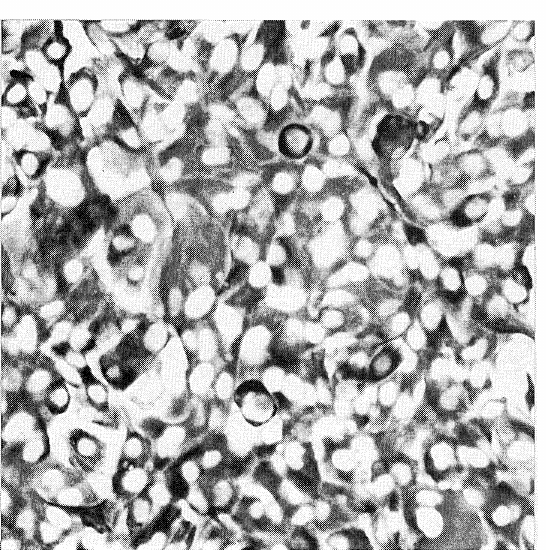
FIGURE 1. Photomicrograph of cultured murine thymus epi- thelial cells. The cells were derived from 14-day-old fetuses and have been grown for 10 days in serum-free medium. Cells were stained by the PAP method after incubation with antibody against cytokins 6 and 18 (x